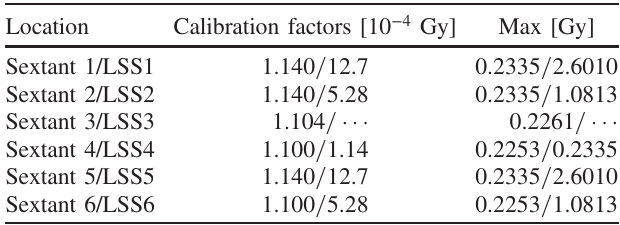
TABLE II. Calibration factors a of the SPS BLMs and maximum signal they can read. The calibration factors are used as LSBs. There are no BLMs in